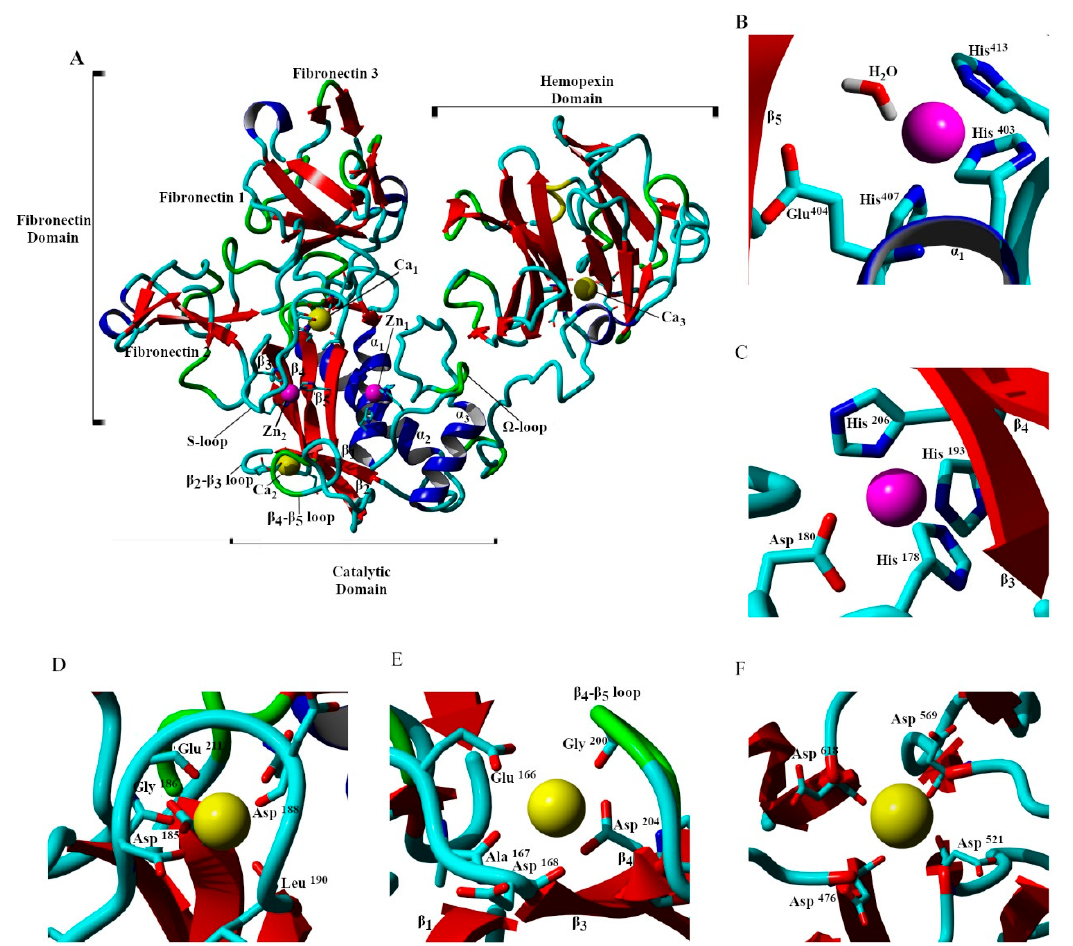
Figure 1. The ribbon diagram of the X-ray crystal structure of 1CK7. The pro-peptide (Pro 31 -Gln 109 ) region is removed, and the unresolved link (Asp 450 -Thr 460 ) connecting the Cat and Hpx domains built with YASARA [16]. Domains, subdomains, and secondary structural features of the catalytic domain are labeled accordingly (blue, α -helix; red, β -sheet; green, β -turn / bend; and aqua, coil) ( A ). The associated ions are shown as van der Waals radii with Zn 2 + pink and Ca 2 + yellow. The catalytic Zn 2 + ion 1 is bound to His 403 , Glu 404 , His 407 , His 413 , and catalytic water ( B ). Zn 2 + ion 2 is bound to His 178 , Asp 180 , His 193 , and His 206 ( C ). Ca 2 + ion 1 is bound to Asp 185 , Gly 186 , Asp 188 , Leu 198 , Asp 208 , and Glu 211 ( D ). Ca 2 + ion 2 is bound to Glu 166 , Ala 167 , Asp 168 , Gly 200 , Gly 202 , and Asp 204 ( E ). Ca 2 + ion 3 is bound to Asp 476 , Asp 521 , Asp 569 , and Asp 618 ( F ). Table 1. Distances between ions and the interacting matrix metaloproteinase-2 (MMP-2) residue atoms and associated binding geometry identified from the 1CK7 X-ray crystal structure. Binding geometries and distances were determined using CheckMyMetal a,b,c .